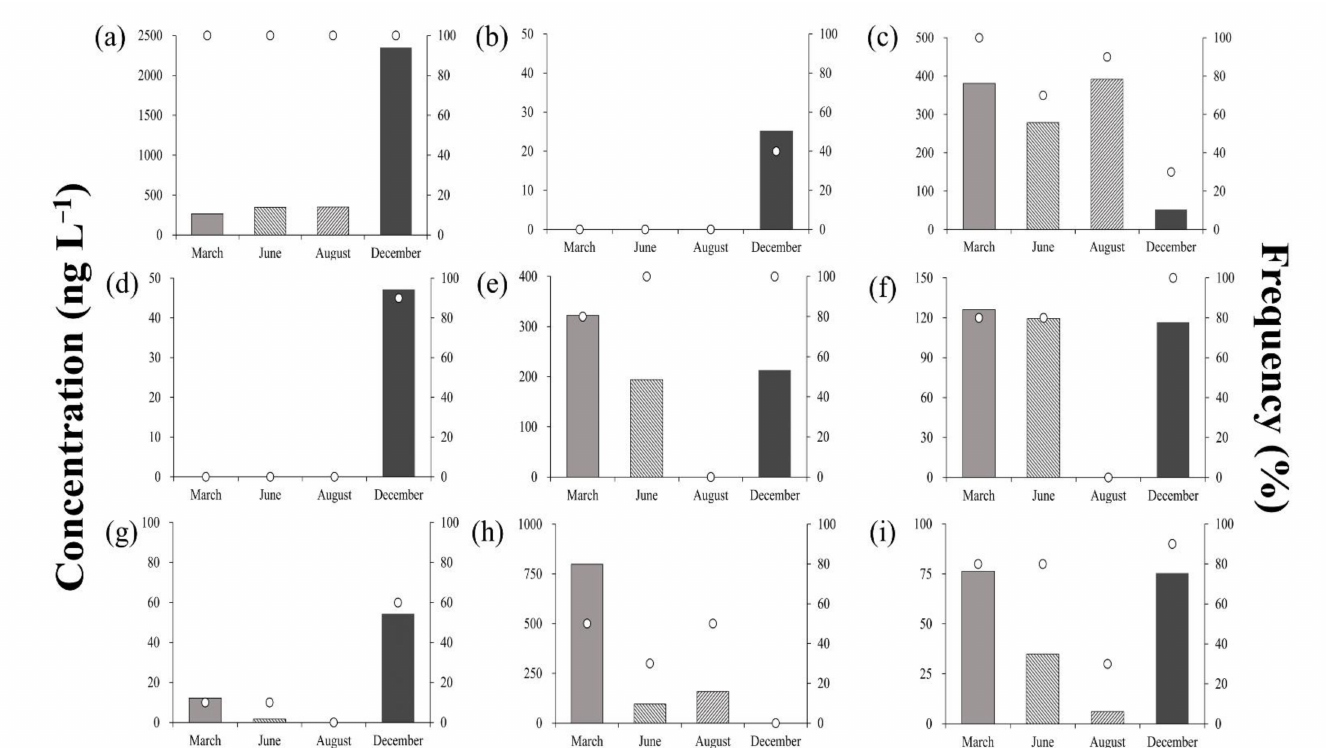
Figure 3. Residual concentrations and detection frequencies of antibiotics in surface water during the sampling campaigns; ( a ) Lincomycin, ( b ) Sulfachloropyridazine, ( c ) Sulfadimethoxine, ( d ) Sulfadiazine, ( e ) Sulfamethazine, ( f ) Sulfamethoxazole, ( g ) Sulfaquinoxaline, ( h ) Sulfathiazole, ( i )